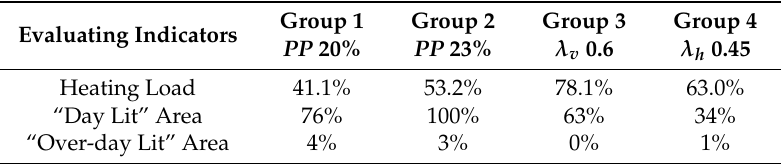
Table 4. Alternatives with the best combined performance in the 4